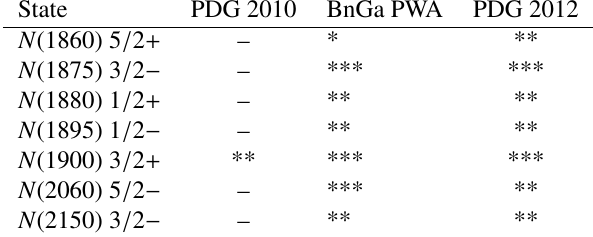
Table 1. Status of nucleon resonance states at around 2 GeV mass in PDG and PWA[1].